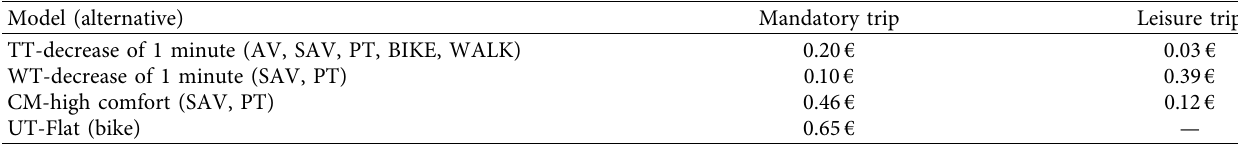
Table 7: Willingness to pay estimations for the mandatory and leisure models.